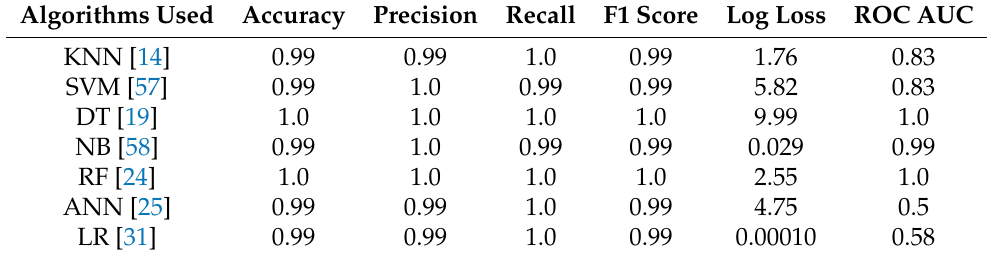
Table 15. DDoS TCP results.